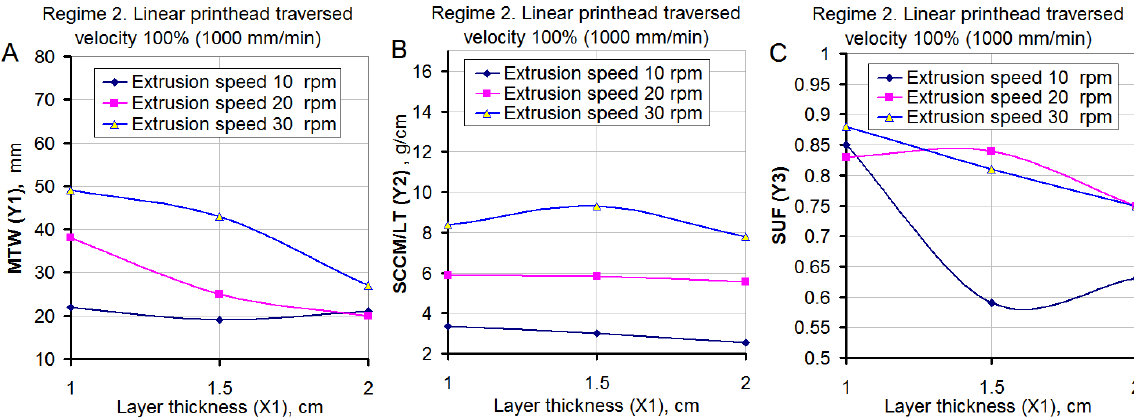
Figure 7. Influence of layer thickness on different print parameters when the linear printhead traversed velocity is constant (Regime 2): ( A ) maximum track width; ( B ) specific consumption of the “concrete mixture/layer thickness” ratio; ( C ) section utilization factor.